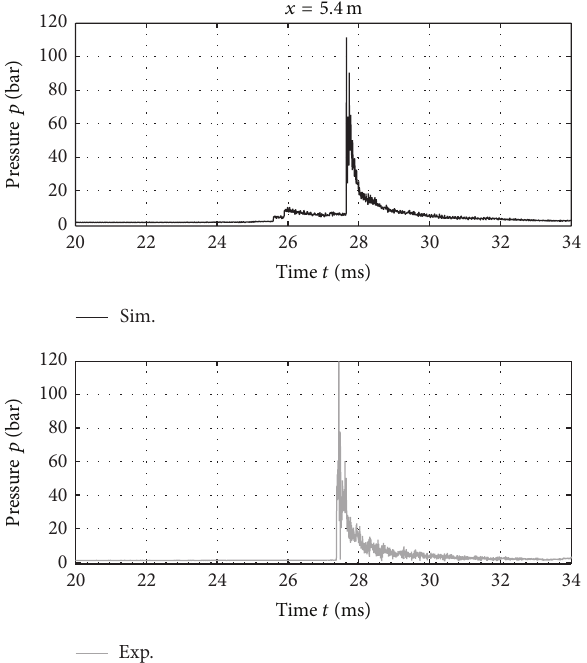
Figure 8: Pressure records from the sensor mounted on the end wall. Mixture with 15% H 2 (max. concentration